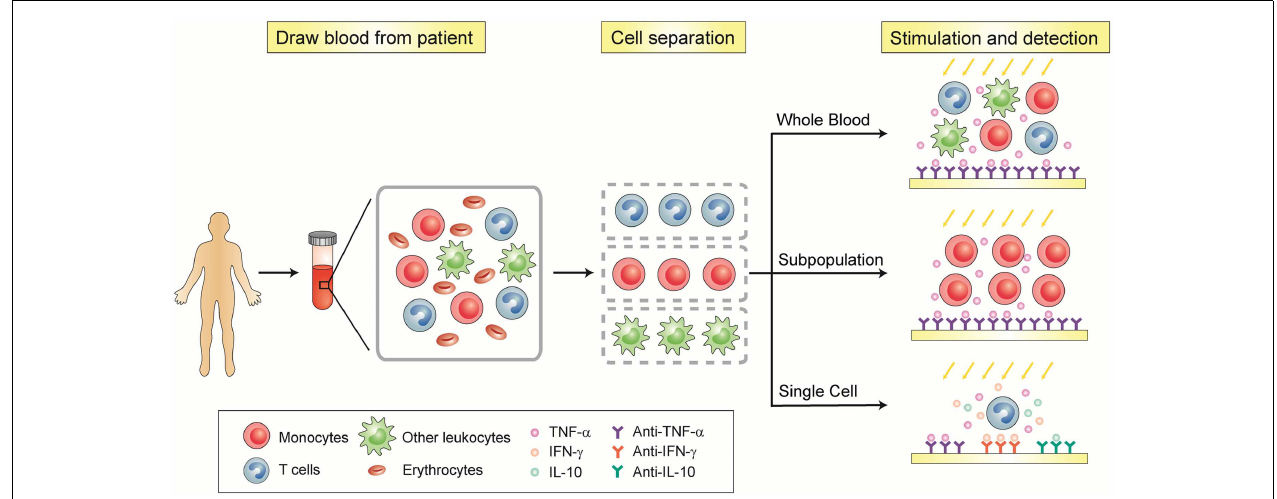
FIGURE 1 | Schematic of functional immunophenotyping of immune cells